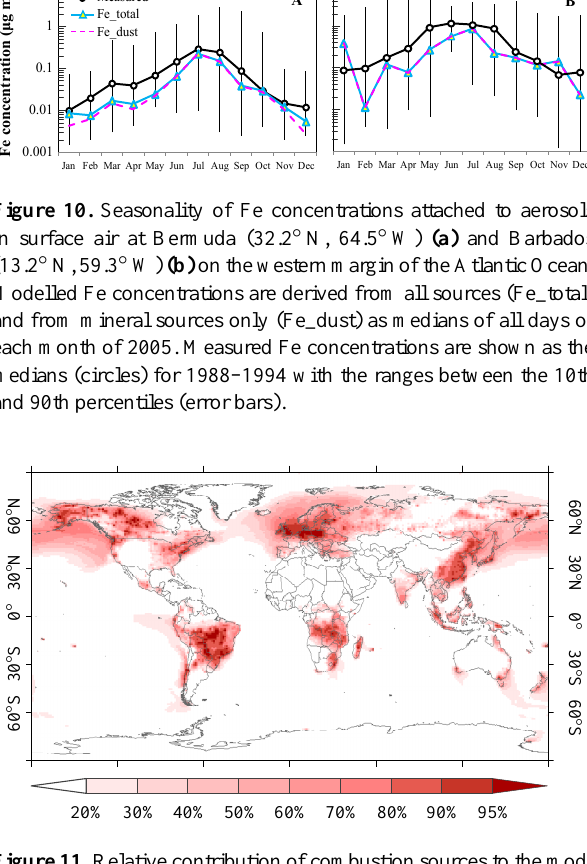
Figure 11. Relative contribution of combustion sources to the mod- elled Fe concentrations attached to aerosols in surface